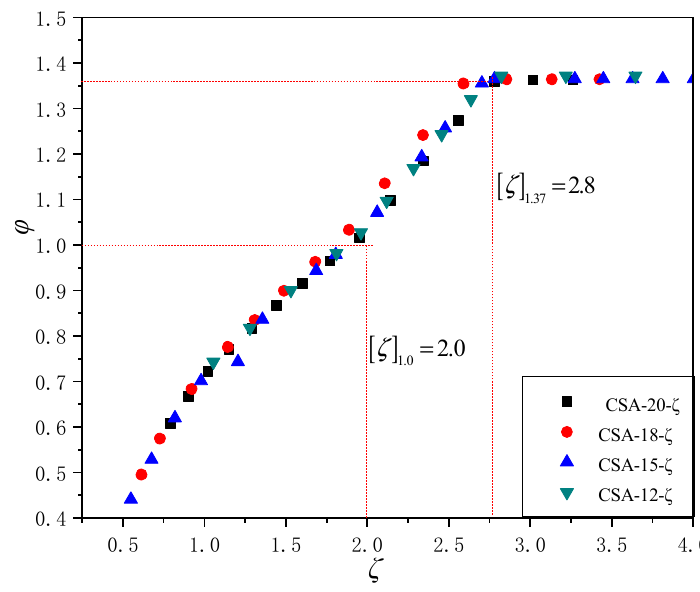
ϕ Figure 9. - ζ of the CSA-BRBs in Table 2. Figure 9. ϕ - ζ of the CSA-BRBs in Table 2.